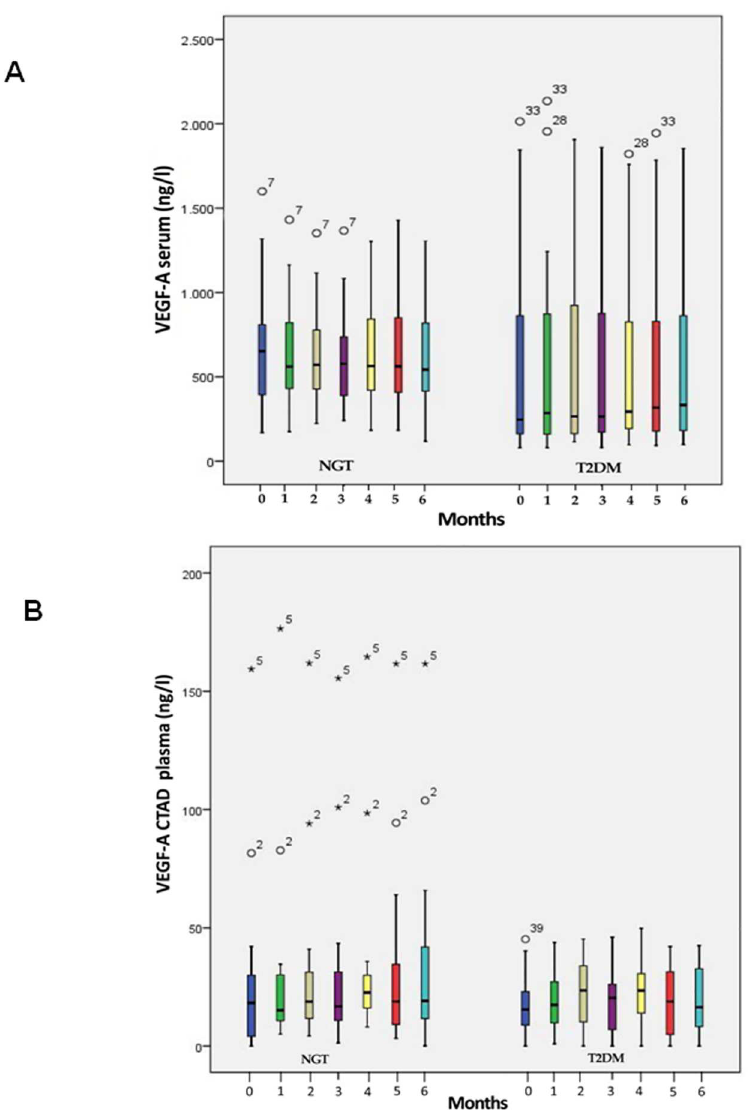
Fig 2. A) Boxplot of VEGF-A concentrations in serum of subjectswith normalglucose tolerance (NGT) and patients with type 2 diabetes mellitus (T2DM) over an observation periodof 6 months. B) Boxplot of VEGF-A concentrations in CTAD plasma of subjects with normal glucosetolerance (NGT) and patients with type 2 diabetes mellitus (T2DM) over an observation periodof 6 months. The lower border of the box plots represent the 25th percentileand the upper border representsthe 75th percentile ± SD. ˚ = patient with a value < 3 times box size, * = patient with a value (cid:21) 3 times box size. Number above˚/ * = reflects individual patient